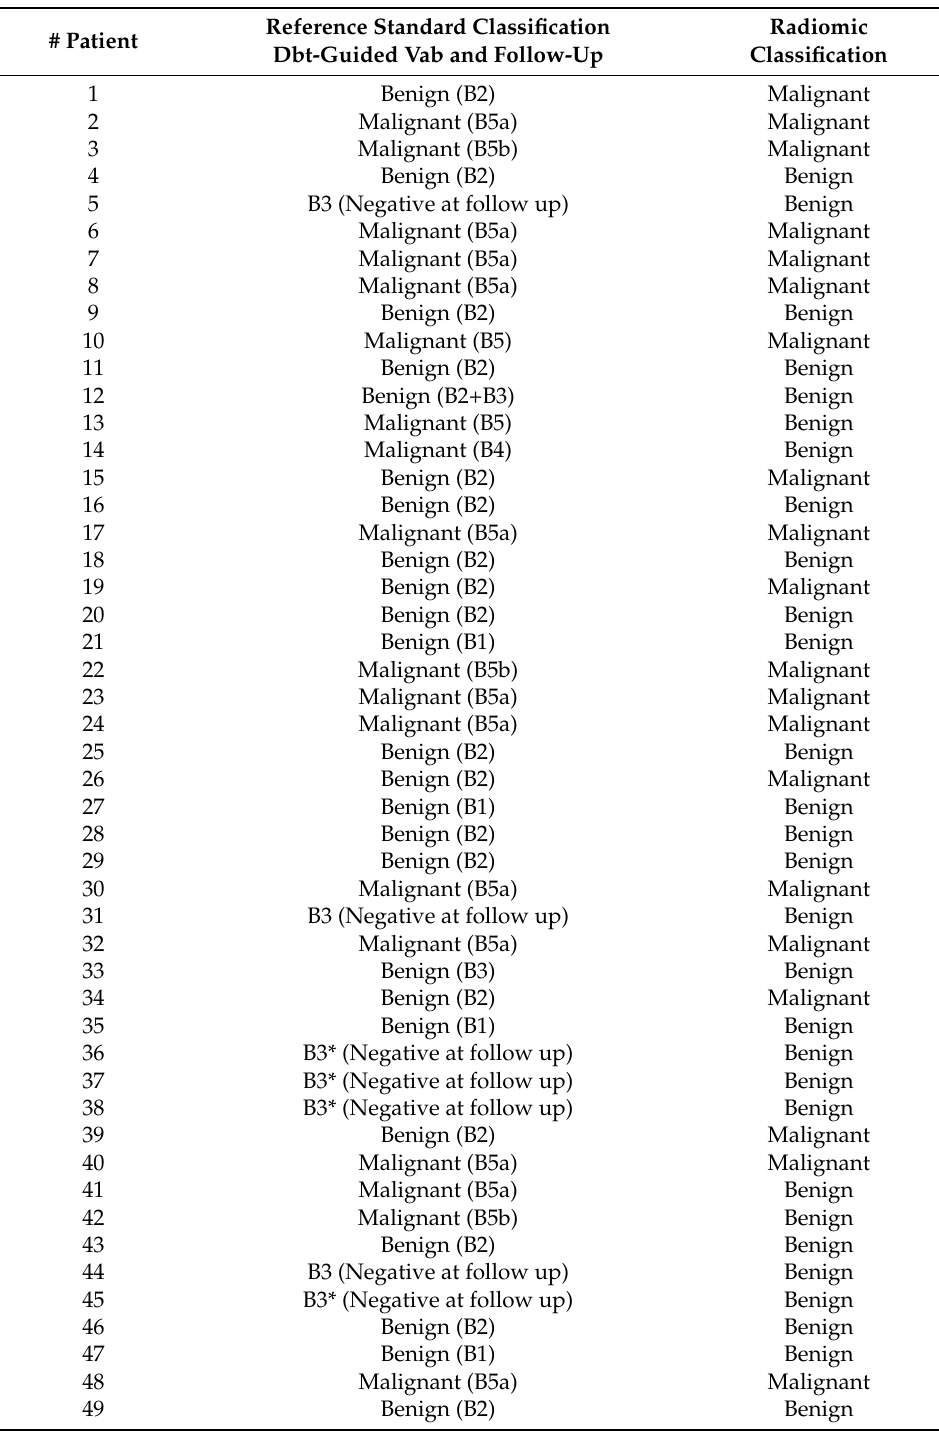
Table 5. Reference standard classification (from DBT-guided VAB and follow-up), and radiomic classification, for each single patient included in the